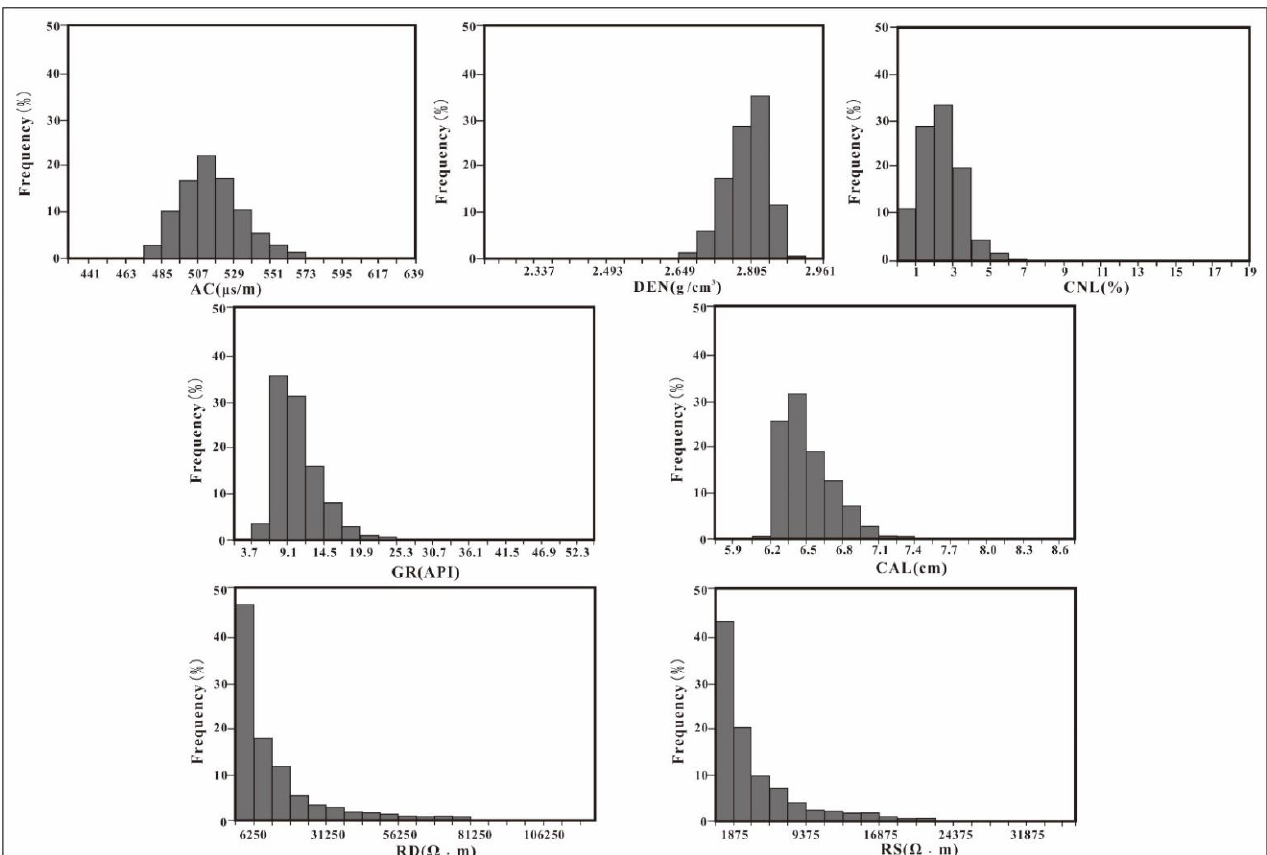
Figure 9. Distribution of logging data of AC, DEN, CNL, GR, CAL, RD and RS of Well#1 in the study area. Table 2. Classification results of the void spaces of the MG carbonate reservoirs (SFT:solution-filling type; CRT:cement-